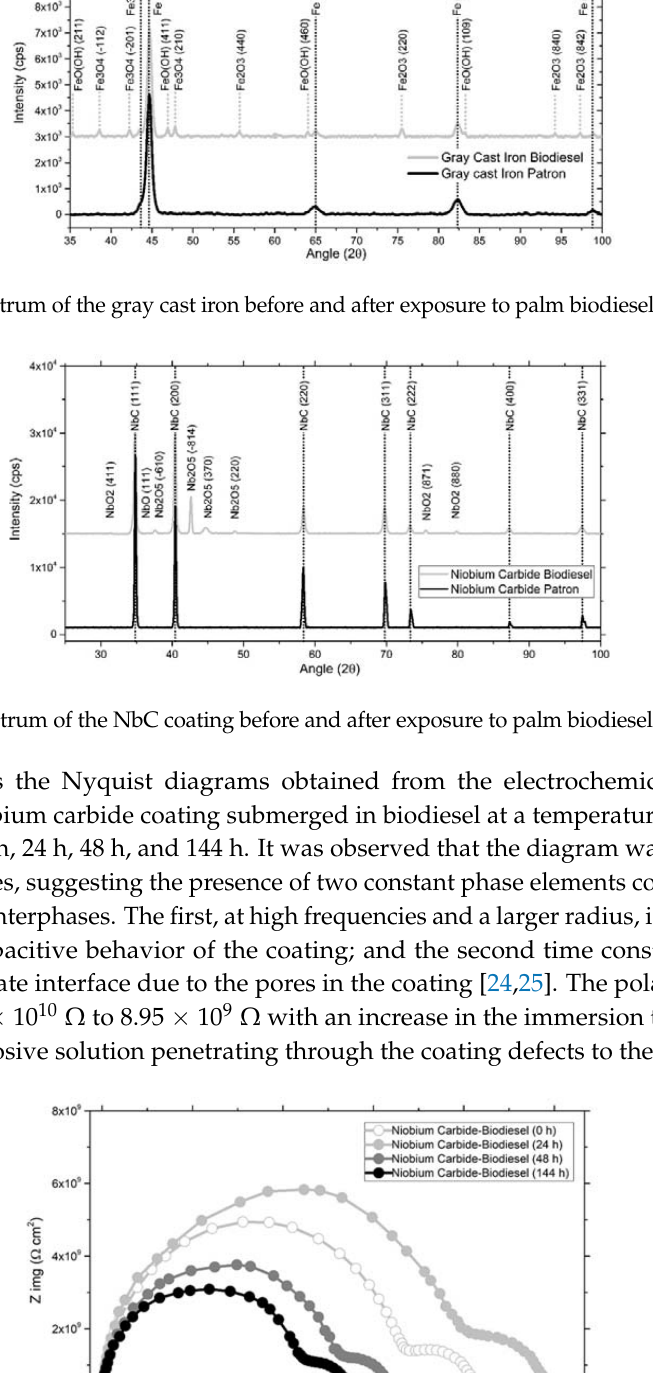
( b ) Figure 6. SEM–FEG micrograph on the surface exposed to palm biodiesel by 1320 h. ( a ) Gray cast iron and ( b ) NbC coating. Figure 7. SEM ‐ FEG Micrograph of NbN coating exposed to palm biodiesel at 1320 h. The X ‐ ray patterns made by the iron smelter before and after the biodiesel corrosion process are